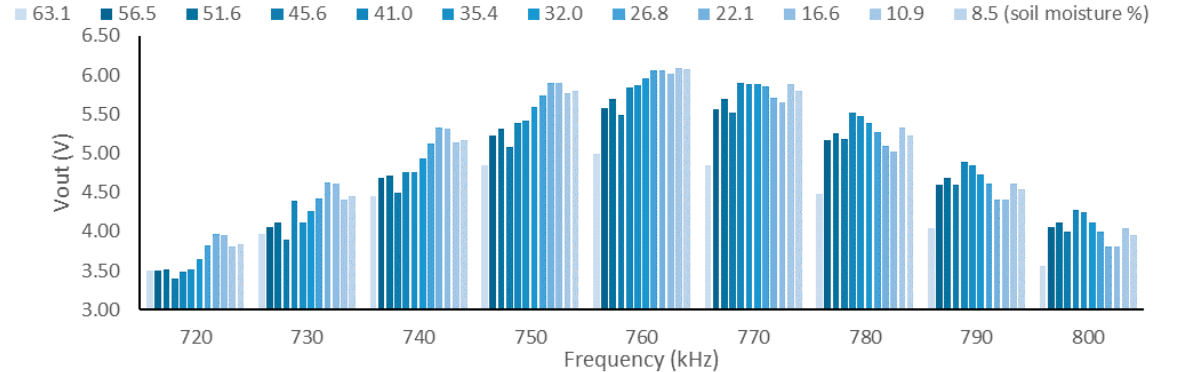
Figure 30. The Vout in the different frequencies tested in prototype NP3.